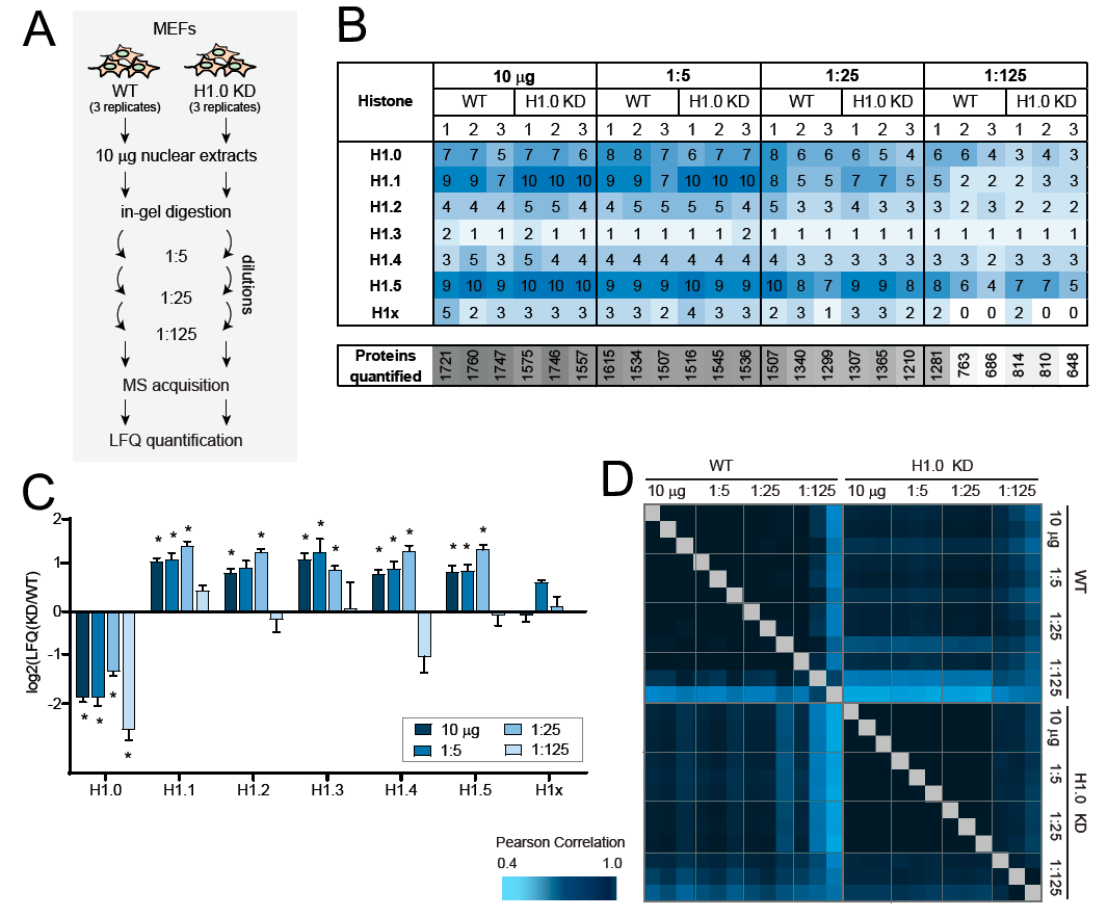
Figure 3. Testing MS–based LFQ quantification of histone H1 variants in low-abundance samples. ( A ) MEFs WT or with lower levels of histone H1 (H1.0 KD) were processed with protocol 2 from Figure 1B. After digestion and prior to MS analysis, the peptides were subjected to 1:5 serial dilutions, starting from 10 µ g of proteins loaded on the gel. ( B ) Number of unique peptides identified from the samples described in ( A ). The number of proteins quantified from the same samples is also indicated. ( C ) Histograms showing the log2 of the LFQ fold-change observed for histone H1 variants in histone H1.0 KD cells relative to WT cells. Error bars represent the SEM from biological triplicates. * p value < 0.05 by multiple t -test comparison. ( D ) Correlation matrix based on Pearson correlation coe ffi cients of log2 MaxLFQ values for histone H1 variant in the nuclear extracts described in ( A